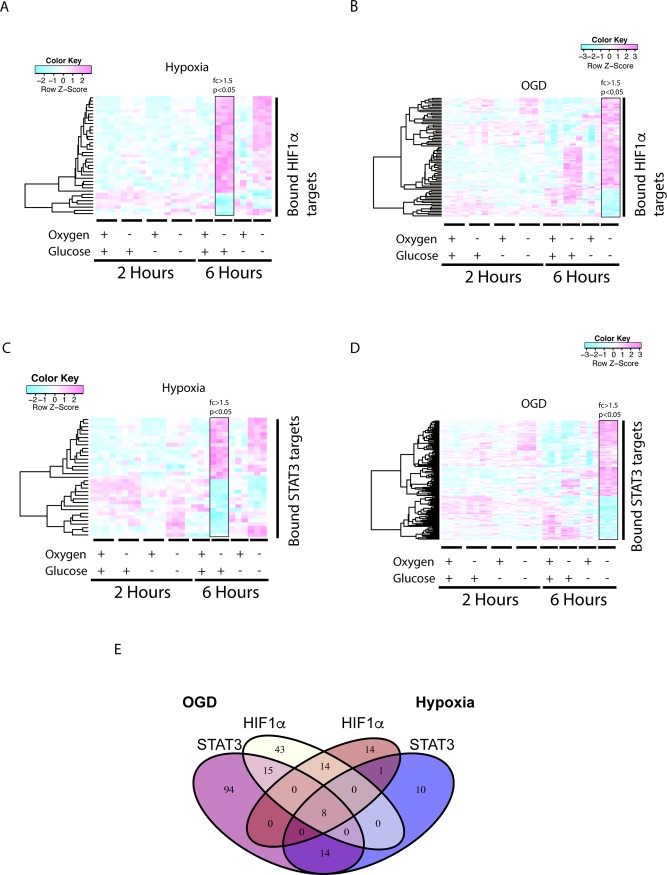
STAT3 dominates the OGD responses but shows equal activity to HIF1α in the hypoxic responses in 6h treated pericytes.STAT3 or HIF1α bound regulated genes (BRGs) with binding site(s) 5Kbp of a TSS were identified by comparing ChIP-seq data to the pericytic Illumina gene expression data. (A) HIF1α alpha BRGs in the 6h hypoxia or (B) OGD condition (fc>1.5, p <0.05) was plotted in a heat map. Panel (C) shows STAT3 BRGs in the hypoxia and (D) OGD condition plotted in a heat map. (E) A Venn diagram was constructed to highlight the differences in STAT3 or HIF1α BRG distribution between 6 h hypoxic and OGD conditions.